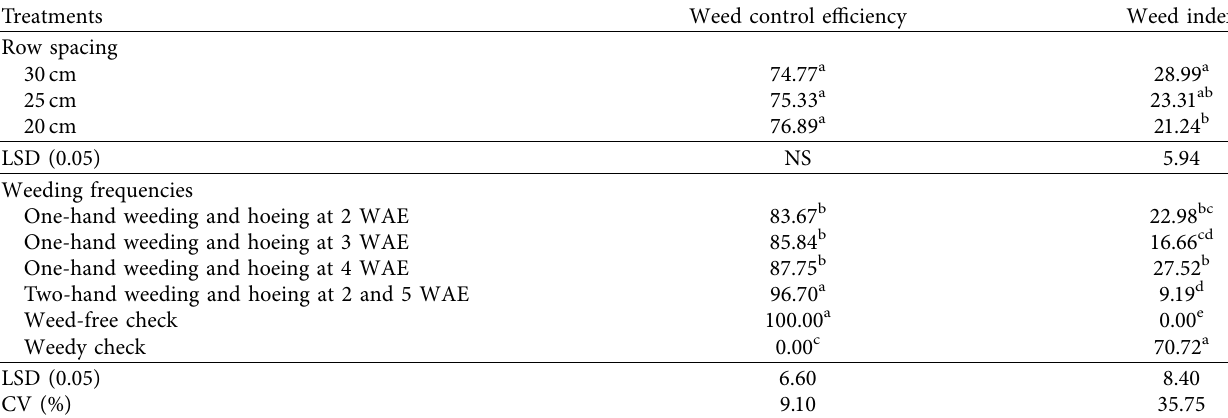
Table 3: Main effect of row spacing and weeding frequencies of rice on weed control efficiency (%) and weed index (%) at Kuja in 2020 main cropping